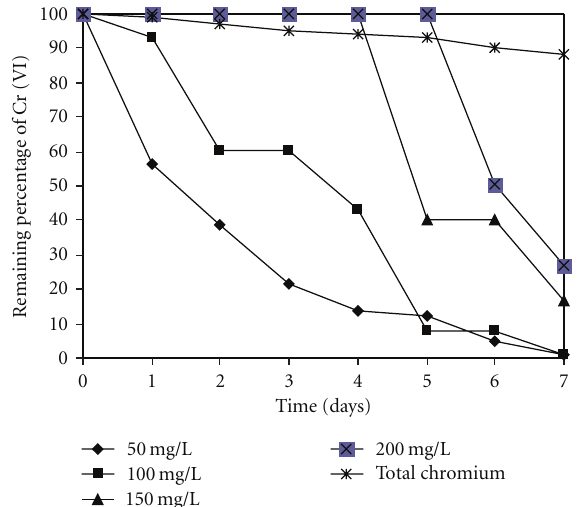
Figure 4: The e ff ect of the concentration of Cr (VI) in solution on the removal. 100 rpm, 28 ◦ C, pH